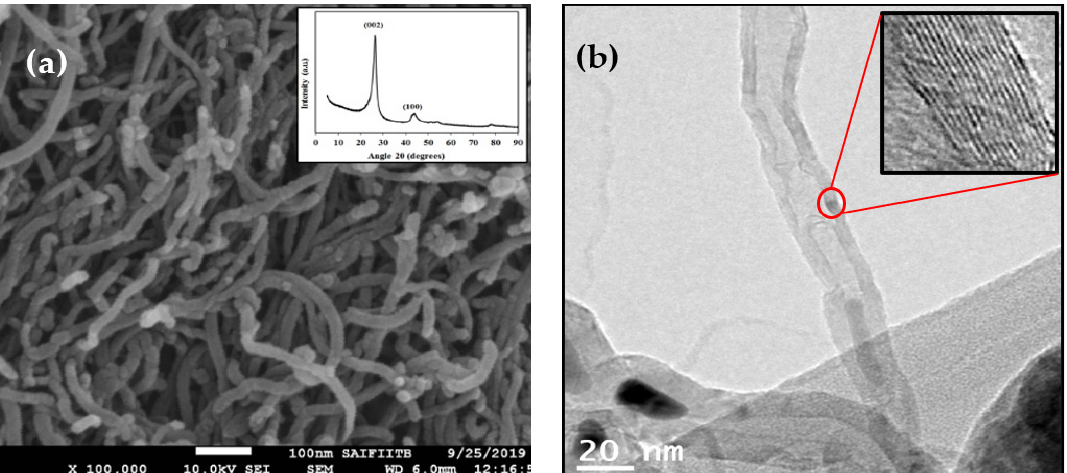
Figure 3. Characterization of MWCNTs: ( a ) scanning electron microscopy; ( b ) high-resolution transmission electron mi- croscopy.